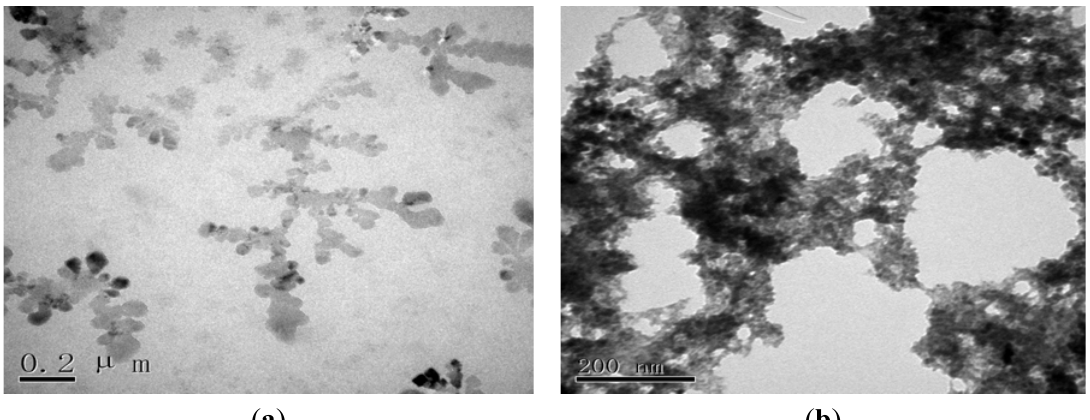
Figure 1. TEM images of ( a ) EVC and ( b ) EVC-AFP